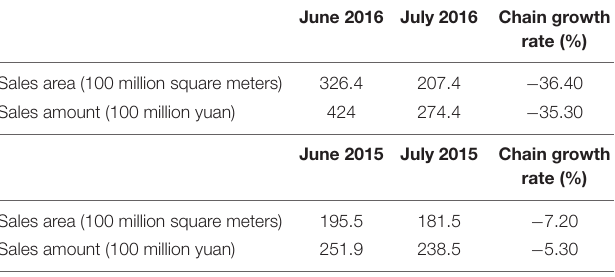
TABLE 1 | Sales scale of Vanke in July 2016.